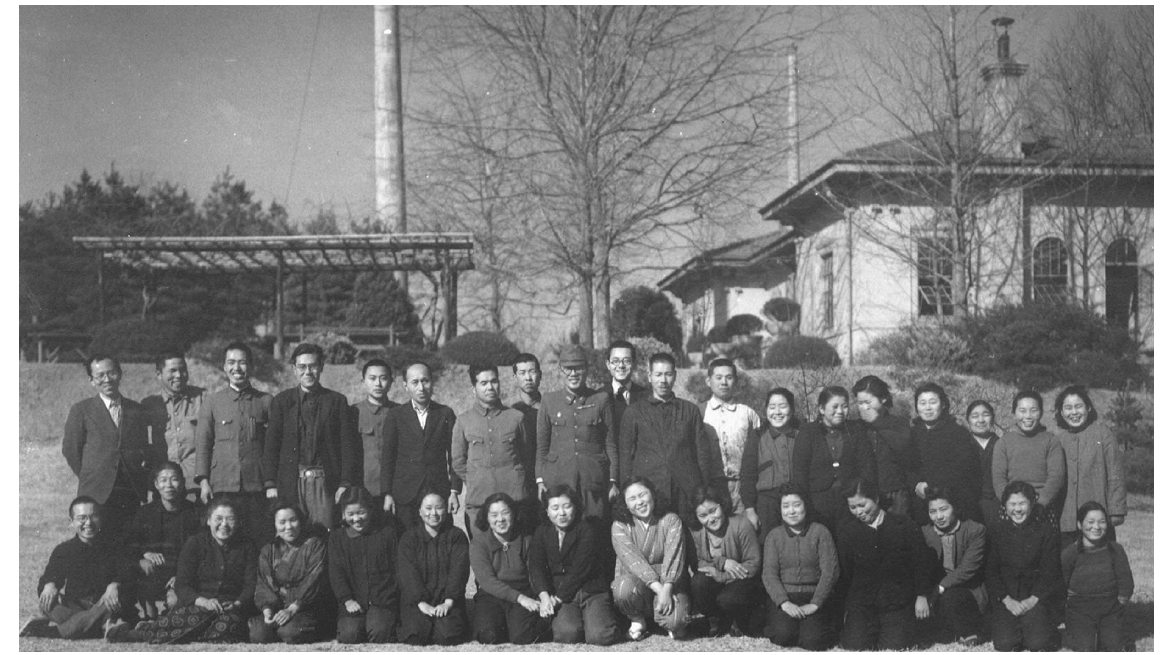
Figure 16. Staff members at Kakioka in February 1945 (photo supplied by Kakioka Magnetic Observatory).